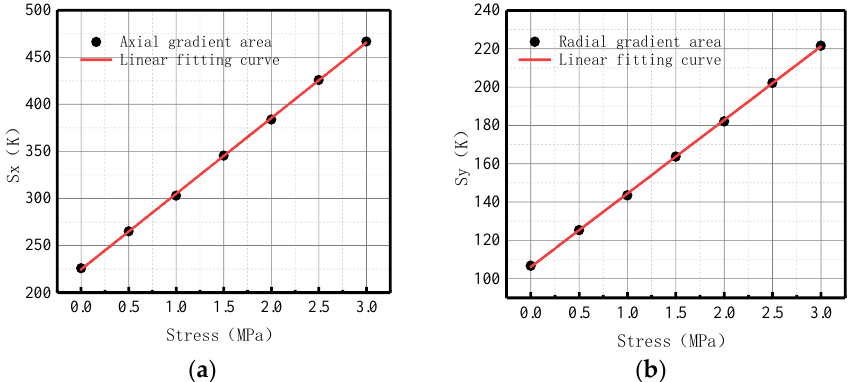
Figure 11. S ( K ) variation with internal pressure. ( a ) Axial component of S ( K ); ( b ) radial component of S ( K ).